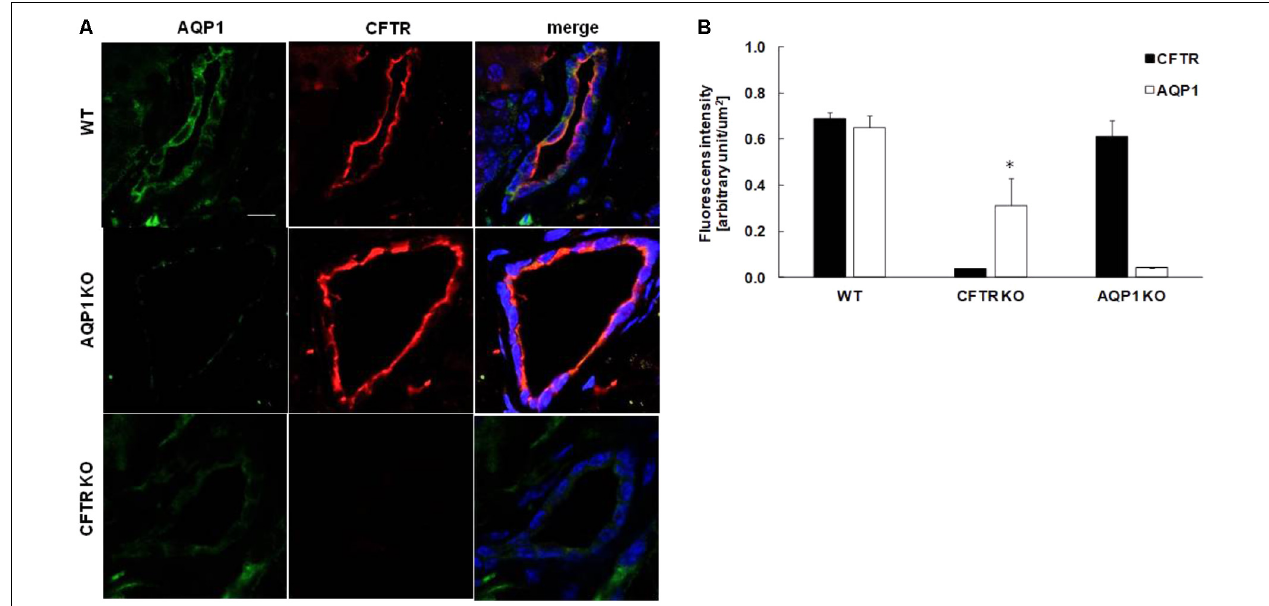
FIGURE 3 | Expression of AQP1 and CFTR in the pancreas of knock out mice. (A) Representative immunofluorescence staining of AQP1 and CFTR in wild type (WT, upper line), AQP1 knock out (AQP1 KO, middle line) and CFTR KO (bottom line) mice. Pictures were taken at 40 × magnification. Pancreas slices were excited at 405 (Dapi), 488 (Alexa fluor 488) and 568 (Alexa fluor 568) nm and emissions were collected at 453, 516, and 603 nm, respectively. Scale bar represents 10 µ m. (B) Summary bar chart shows the mean fluorescence intensity in the ductal cells normalized to the ductal area and expressed in arbitrary units/ µ m 2 . Data are presented as means ± SEM. ∗ p ≤ 0.05 vs. WT (AQP1), n =